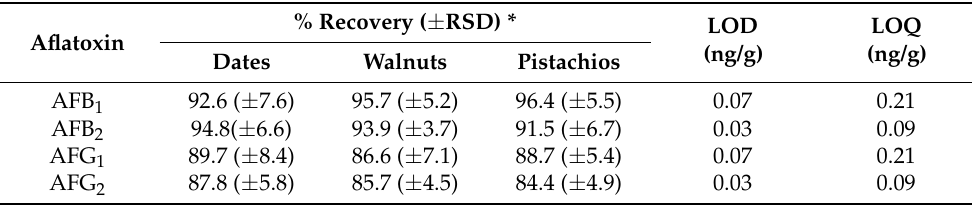
Table 1. Validation parameters for the HPLC-fluorescence technique used for aflatoxin quantitation in dates, walnuts, and